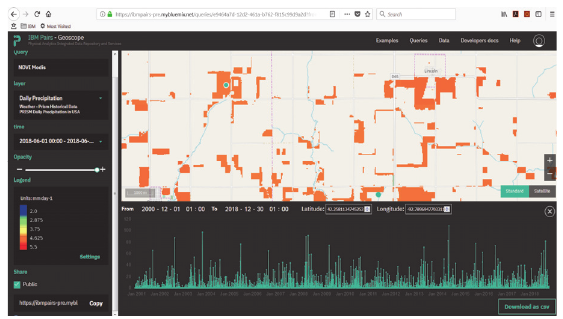
Figure 2: Example of data retrieval and geospatial-temporal browsing using today’s PAIRS Geoscope web-based graphical